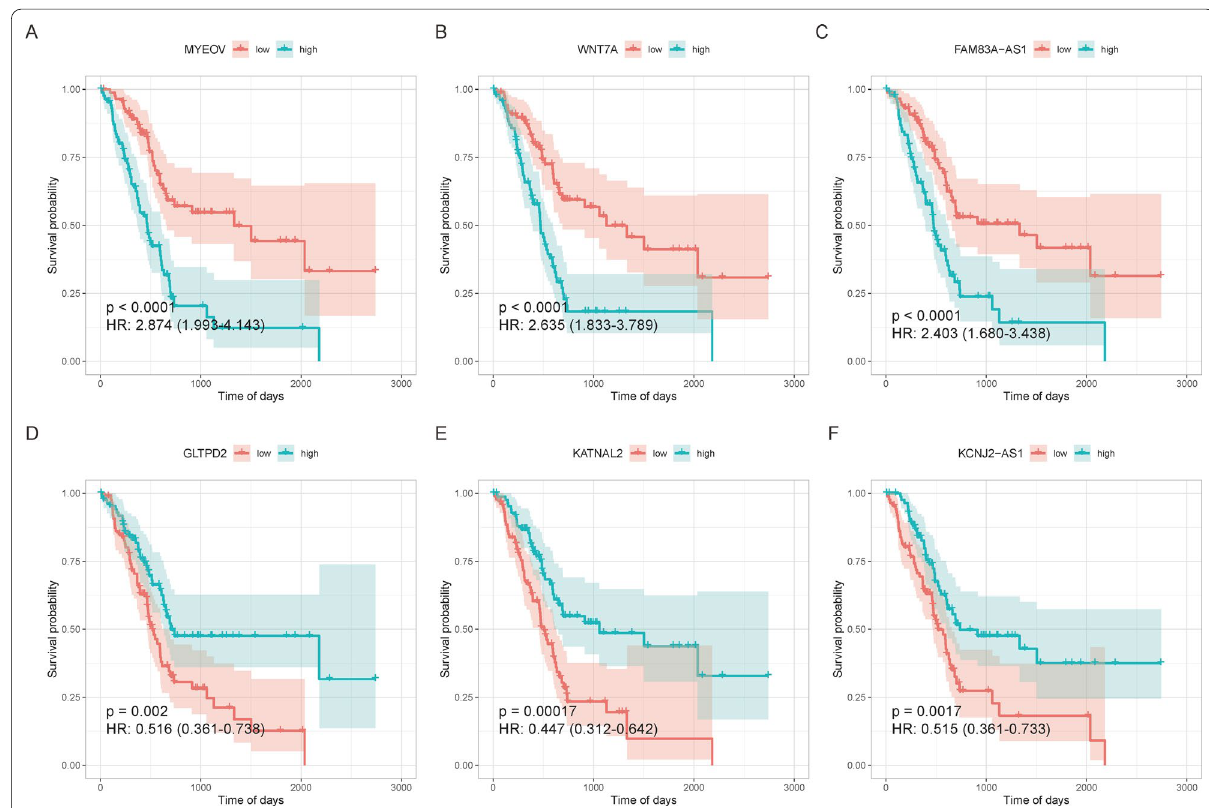
Fig. 5 The KM curves of the top 6 genes exhibiting a significant correlation to disease